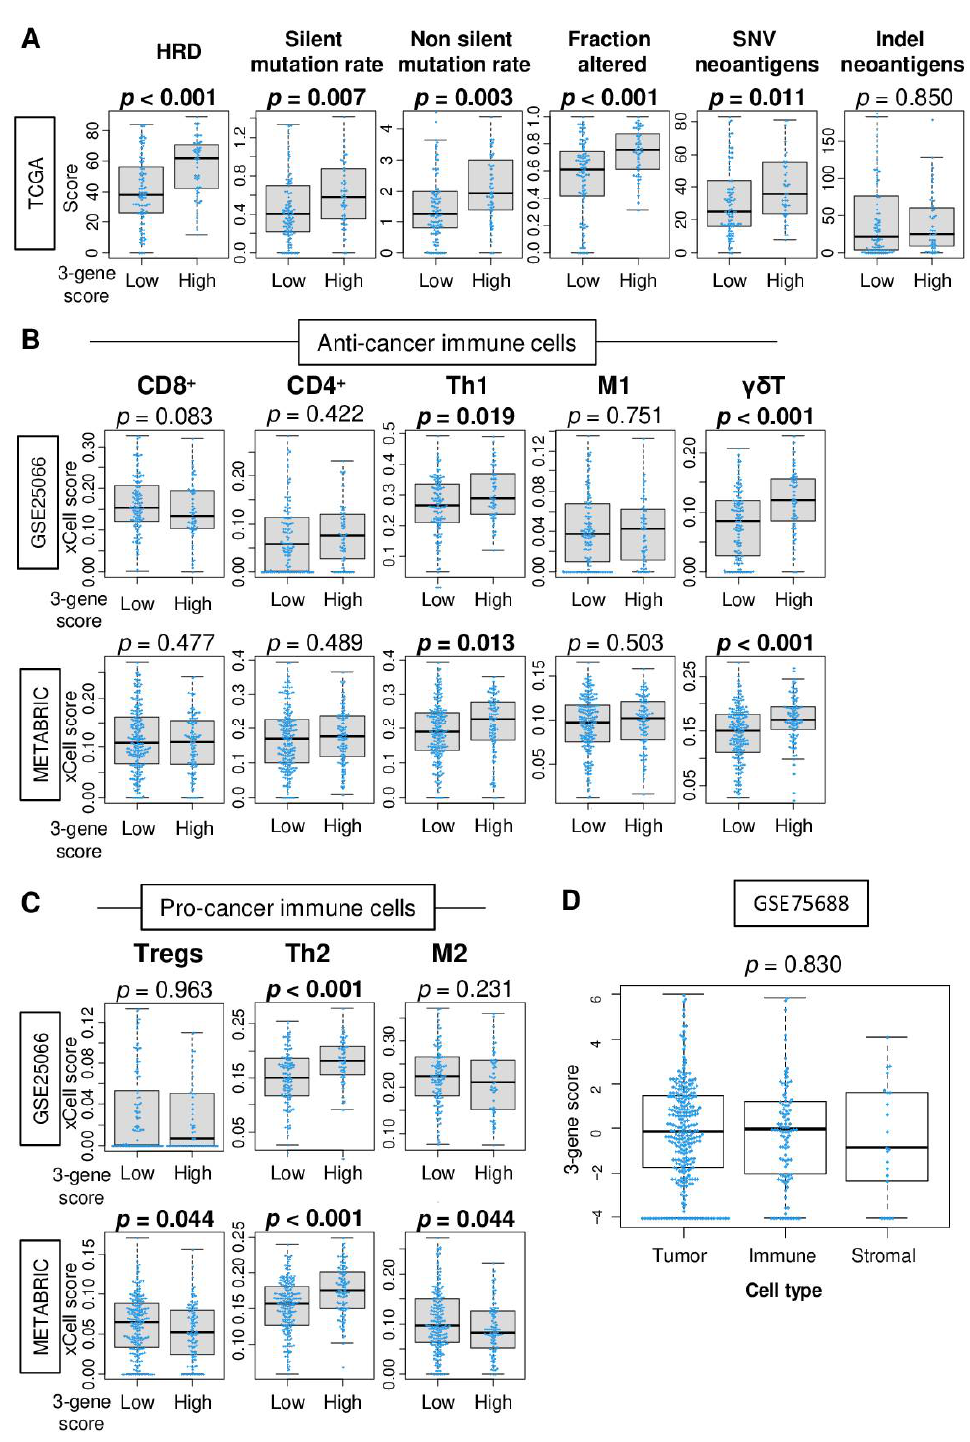
Figure 4. Association of the 3-gene score with mutation load and tumor-infiltrating immune cells. ( A ) Boxplots of the level of the mutation-related score; homologous recombination deficiency (HRD), silent and non-silent mutation load, fraction altered, single-nucleotide variant (SNV), and indel neoantigens by low and high 3-gene score triple-negative breast cancer in the TCGA cohorts. Boxplots of the fraction of ( B ) anti-cancer immune cells; CD8 + T cells, CD4 + T cells, T helper type 1 (Th1) cells, M1 macrophages, γδ T cells and ( C ) pro-cancer immune cells; Regulatory T cells (Tregs), T helper 2 (Th2) cells, M2 macrophages, by low and high 3-gene scores TNBC in the GSE25066 and METABRIC cohorts. ( D ) Boxplots of the 3-gene score by tumor, immune, and stromal cells in single-cell sequence data (GSE75688 cohort). Mann–Whitney U or Kruskal–Wallis test were used to calculate p